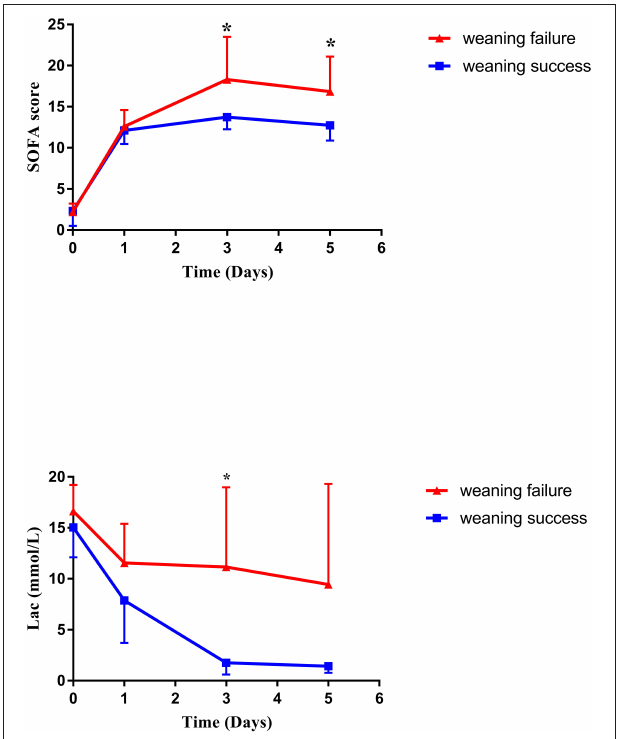
FIGURE 3 | Changes in SOFA score and lactate level during VA-ECMO support. SOFA, sequential organ failure assessment; VA-ECMO, veno-arterial extracorporeal membrane